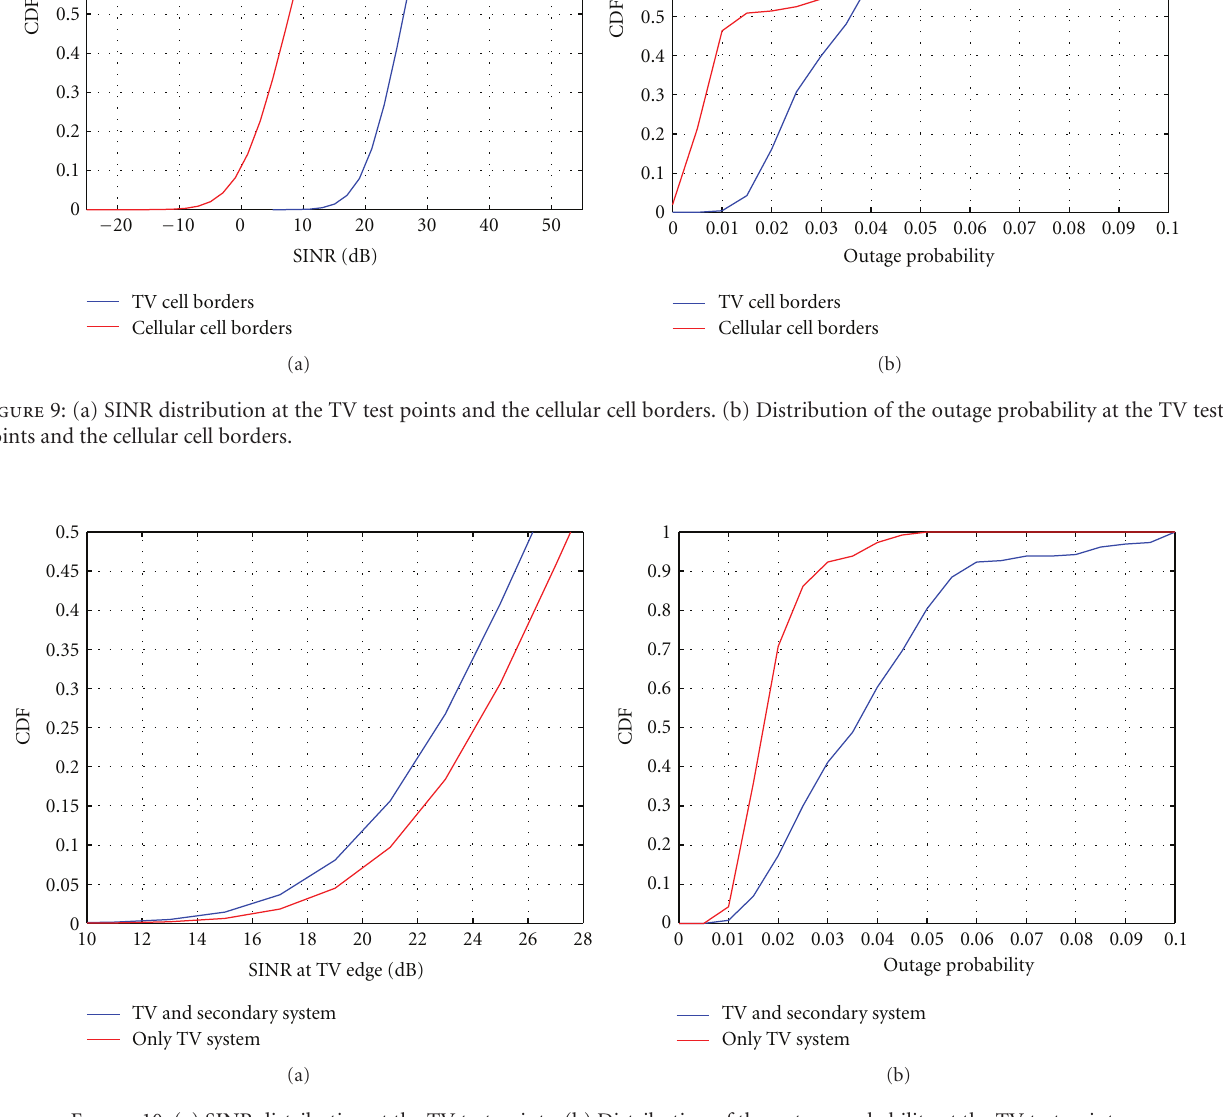
of the SINR at the TV test points and the cellular